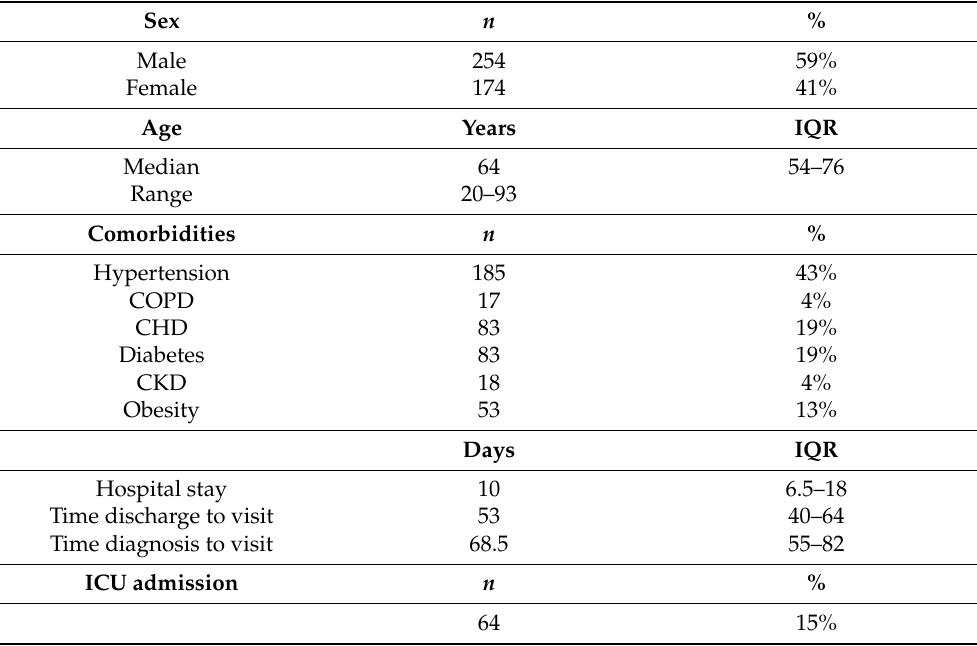
Table 1. Demographic and clinical details of the cohort of 428 patients evaluated at the Careggi University Hospital (Florence, Italy) 4–12 weeks after hospitalization for COVID-19, between